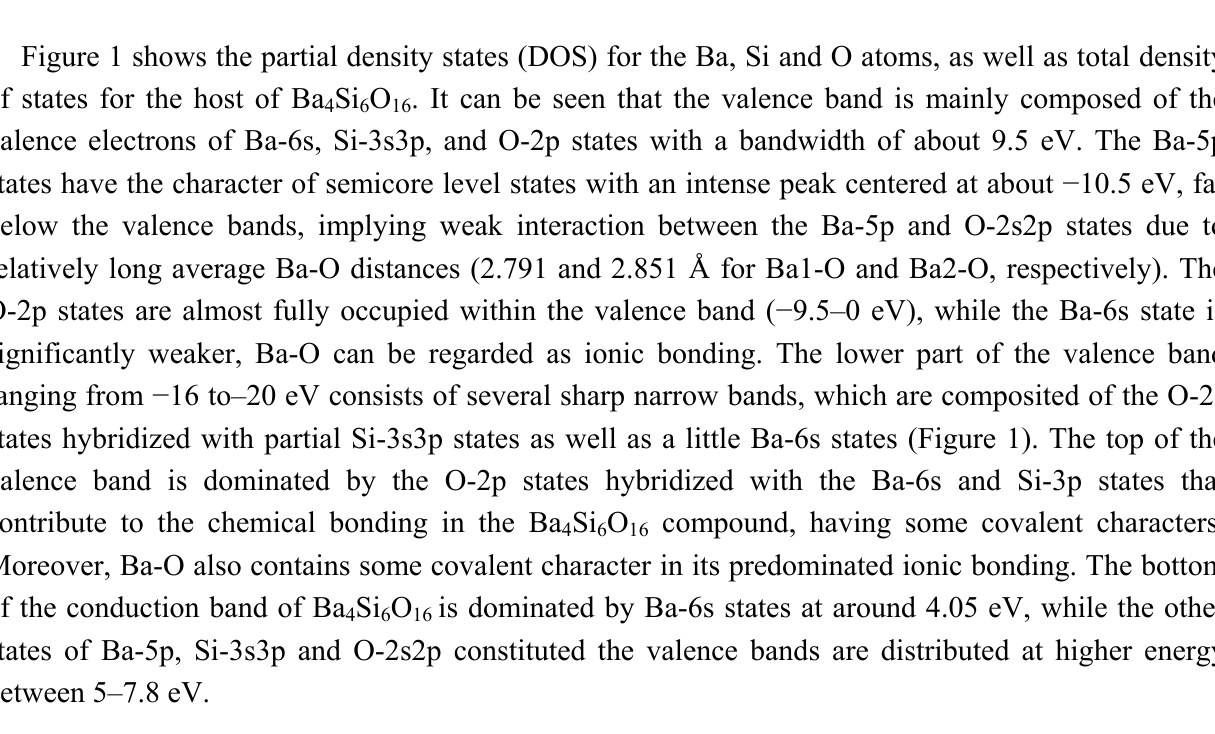
Figure 1. Partial and total density states (DOS) for the host of Ba